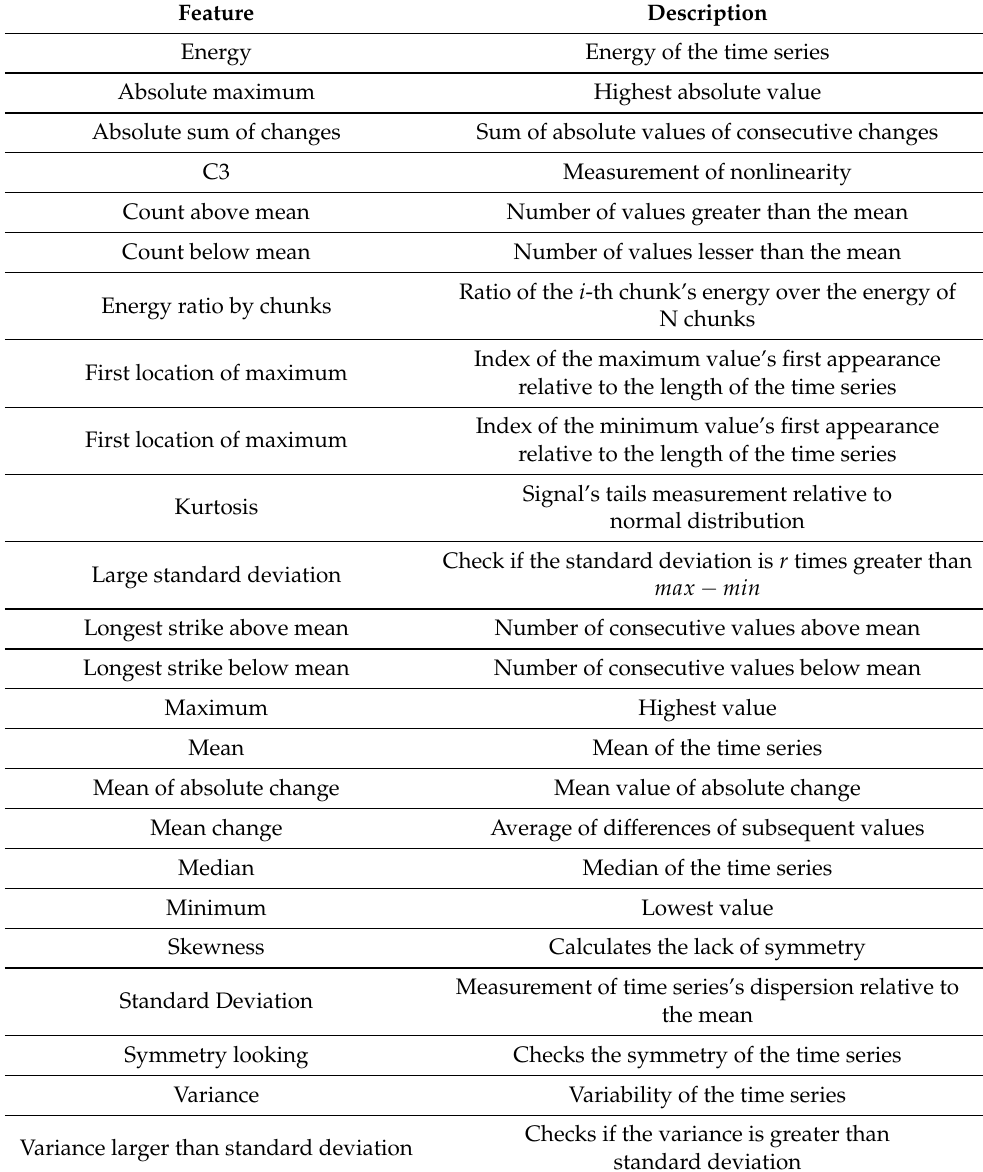
Table 5. List of all the extracted